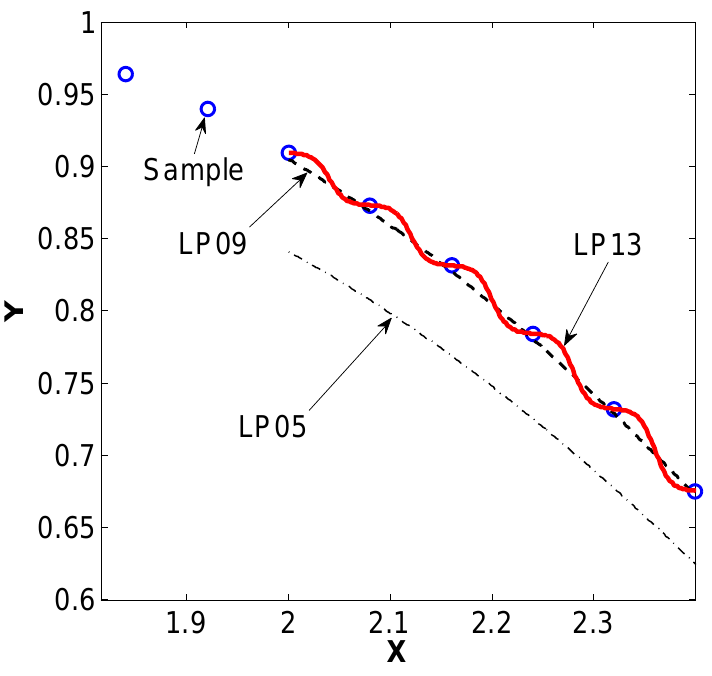
Figure 12. Illustrating a possible pathology. Samples (circles) are uniformly chosen in X , with Y = sin( X ) . Laplacian Pyramids are adopted for interpolation between samples with σ = 10 . Estimated values with the finest level l = 5 , l = 9 and l = 13 are denoted by 0 LP05, LP09 and LP13, respectively. At the latter level, the estimates of derivatives are no longer